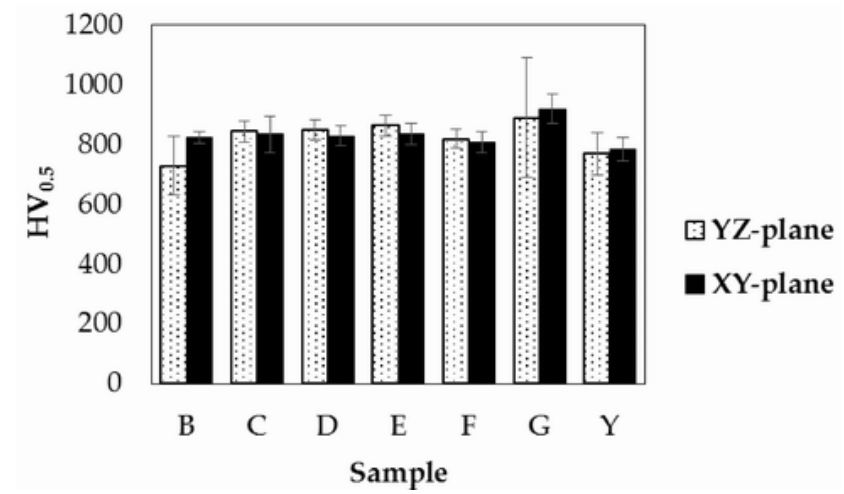
Figure 4. Bar chart reporting the microhardness values of the different samples measured perpendic- ularly and paralleled to the pressing direction.